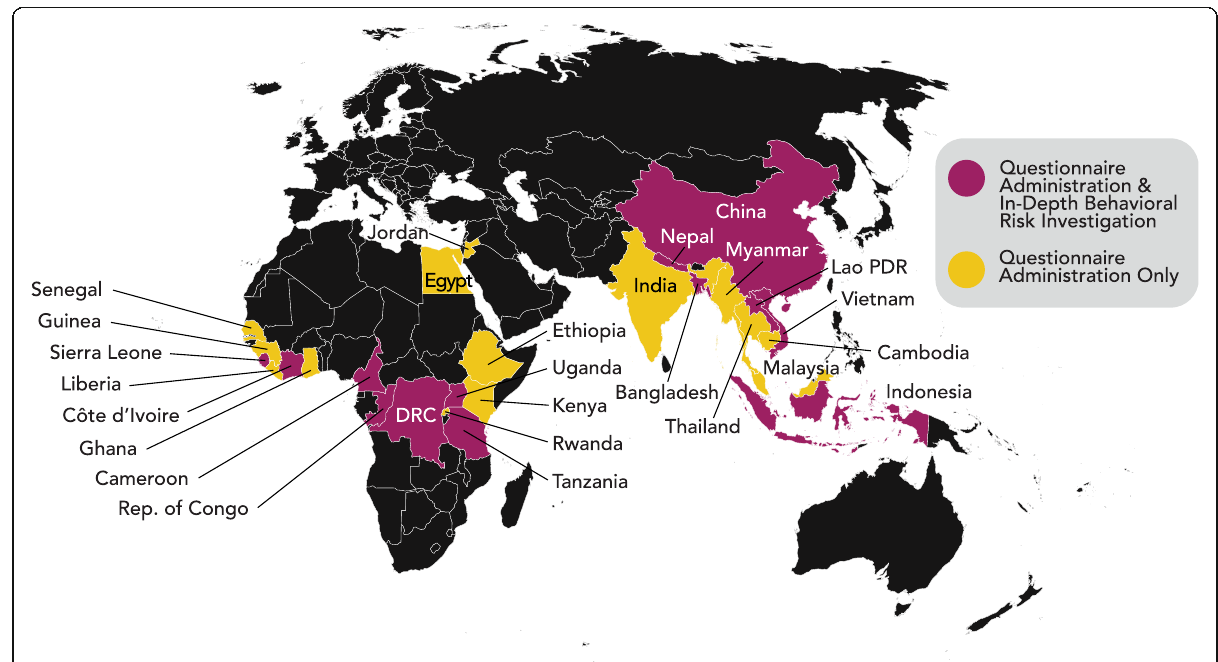
Fig. 1 PREDICT behavioral risk investigations. Twenty-seven out of PREDICT ’ s 28 participating countries implemented questionnaires for quantitative analysis; the exception was Mongolia, which focused exclusively on Influenza A surveillance in wild birds. 13 countries